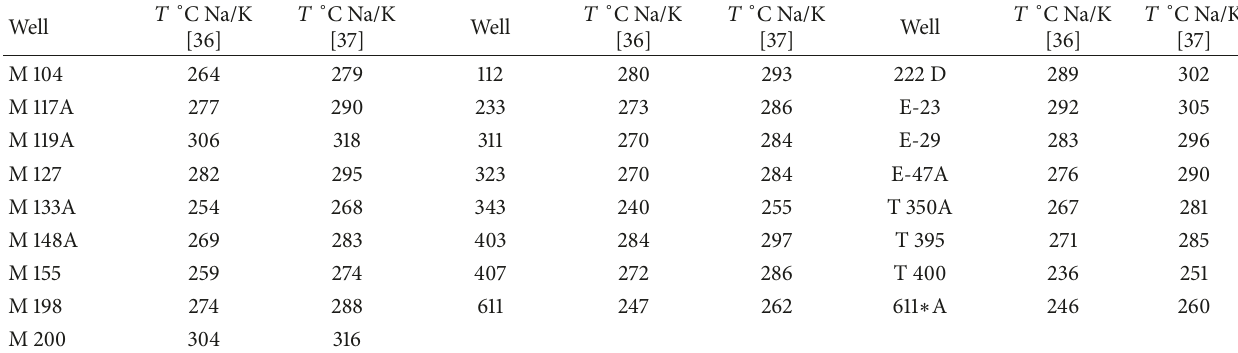
Table 2: Results of Na/K